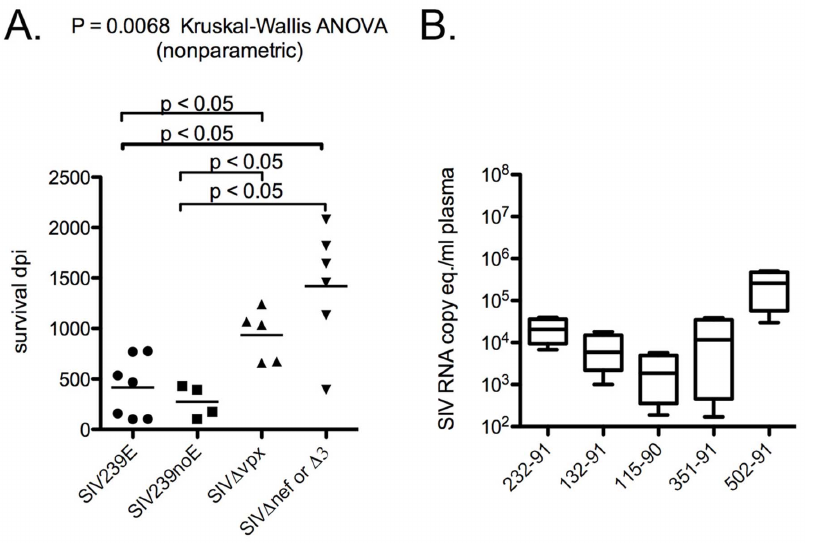
Figure 1. Survival and viral load data. ( A) Survival days post-inoculation (dpi) for rhesus macaques inoculated with SIV D vpx compared to animals inoculated with SIVmac239 (SIV239E with encephalitis or SIV239noE without encephalitis) or other mutant viruses (SIV D nef or SIV D 3. SIV D vpx -infected macaques survived significantly longer with a slower disease progression compared to SIV239E or SIV239noE animals, but did not differ in survival length compared to SIV D nef or SIV D 3. (B) Plasma viral RNA from SIV D vpx -infected rhesus macaques expressed as RNA copy equivalents per ml plasma from chronic disease or near-terminal collections (range 329–1140 dpi, median 730 dpi).